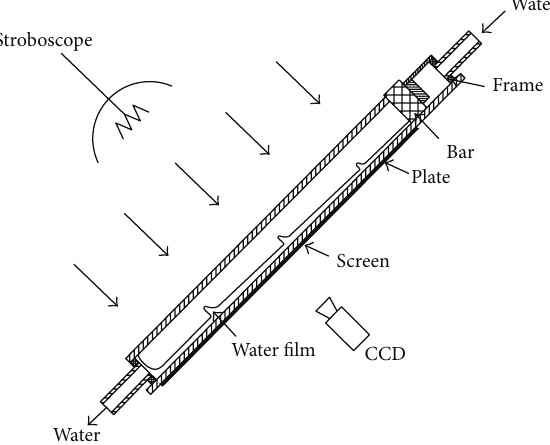
Figure 2: Apparatus of generating a falling water film.